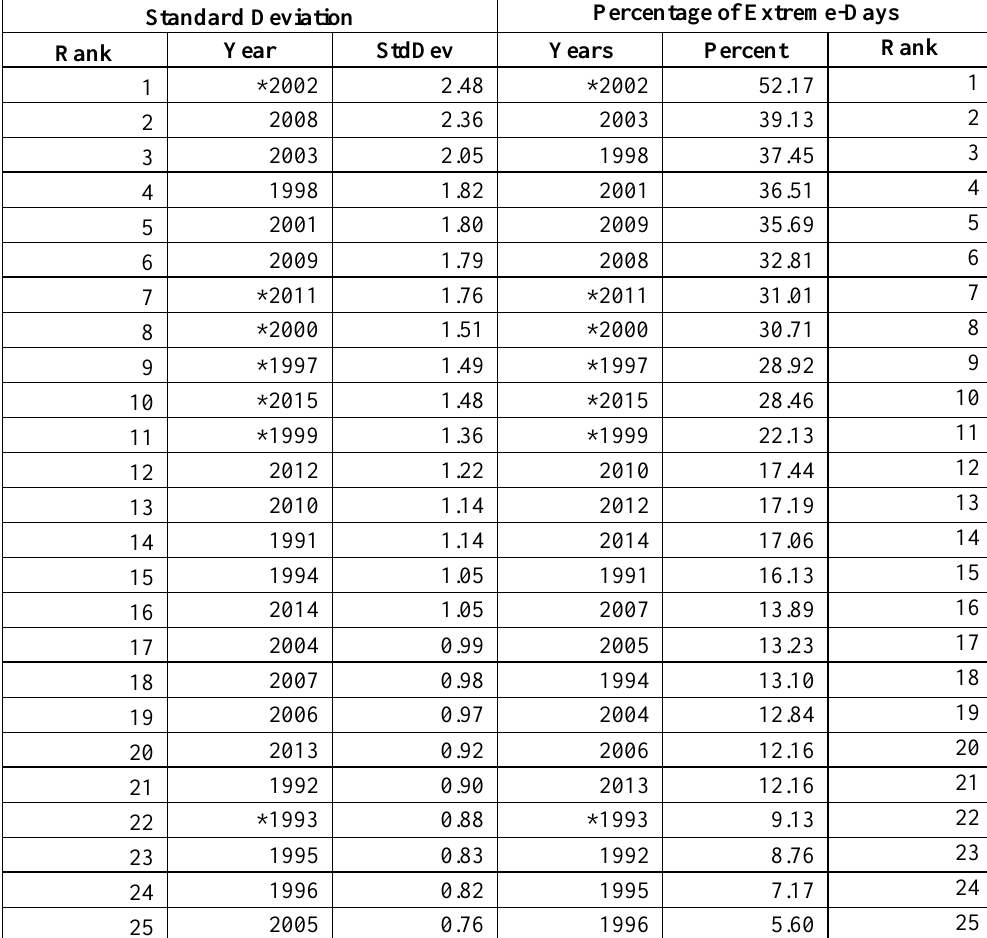
Table 2. Rank of Volatility as Measured by the Standard Deviation and by the Percentage of Extreme Days for 25 years Standard Deviation Percentage of Extreme-Days